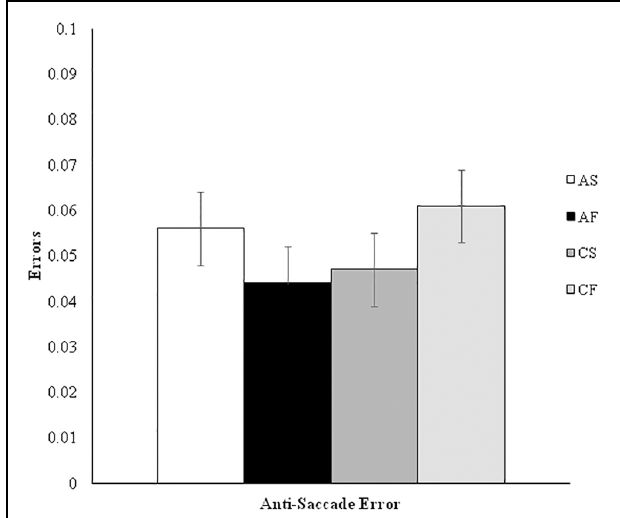
FIGURE 2 | Anti-saccade error by experimental condition. AS, autonomous success; AF, autonomous failure; CS, controlled success; CF, controlled failure.